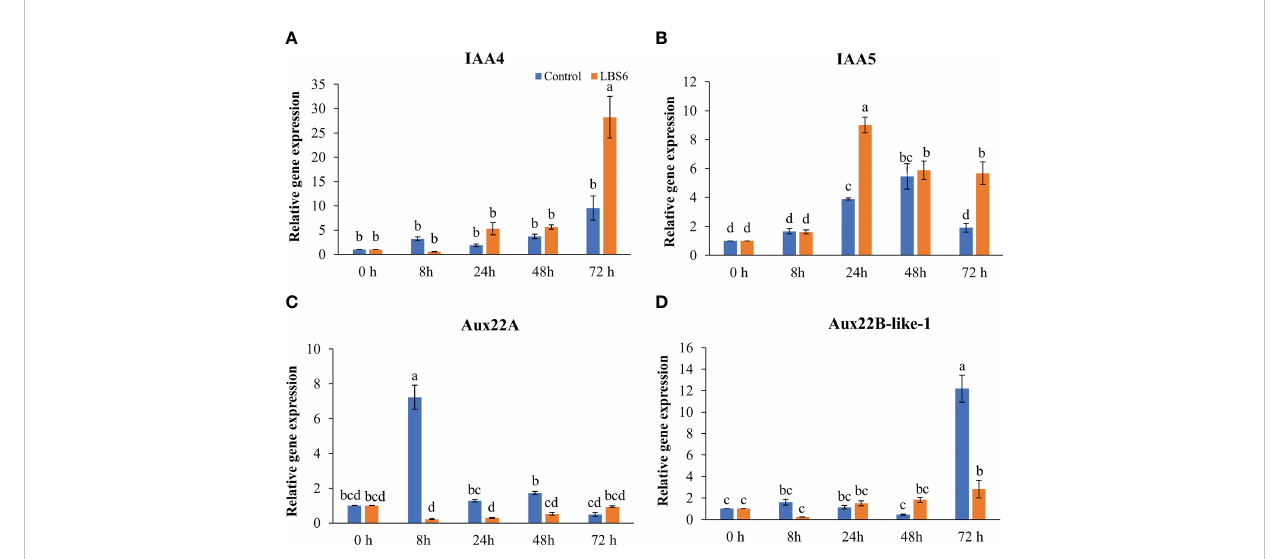
FIGURE 6 LBS6 modulate the expression of (A) IAA4 , (B) IAA5 , (C) Aux22A , and (D) Aux22B-like-1 involved in auxin biosynthesis. The values in the graph represents the relative gene expression. The values were presented as mean ± SE of three independent replicates, and signi fi cantly different mean values were represented by different letters.